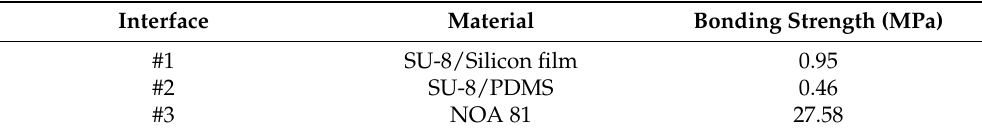
Figure 4. Interfaces involved in film transfer method: ( a ) demolding; ( b ) bonding. Table 2. The bonding strength of each interface.